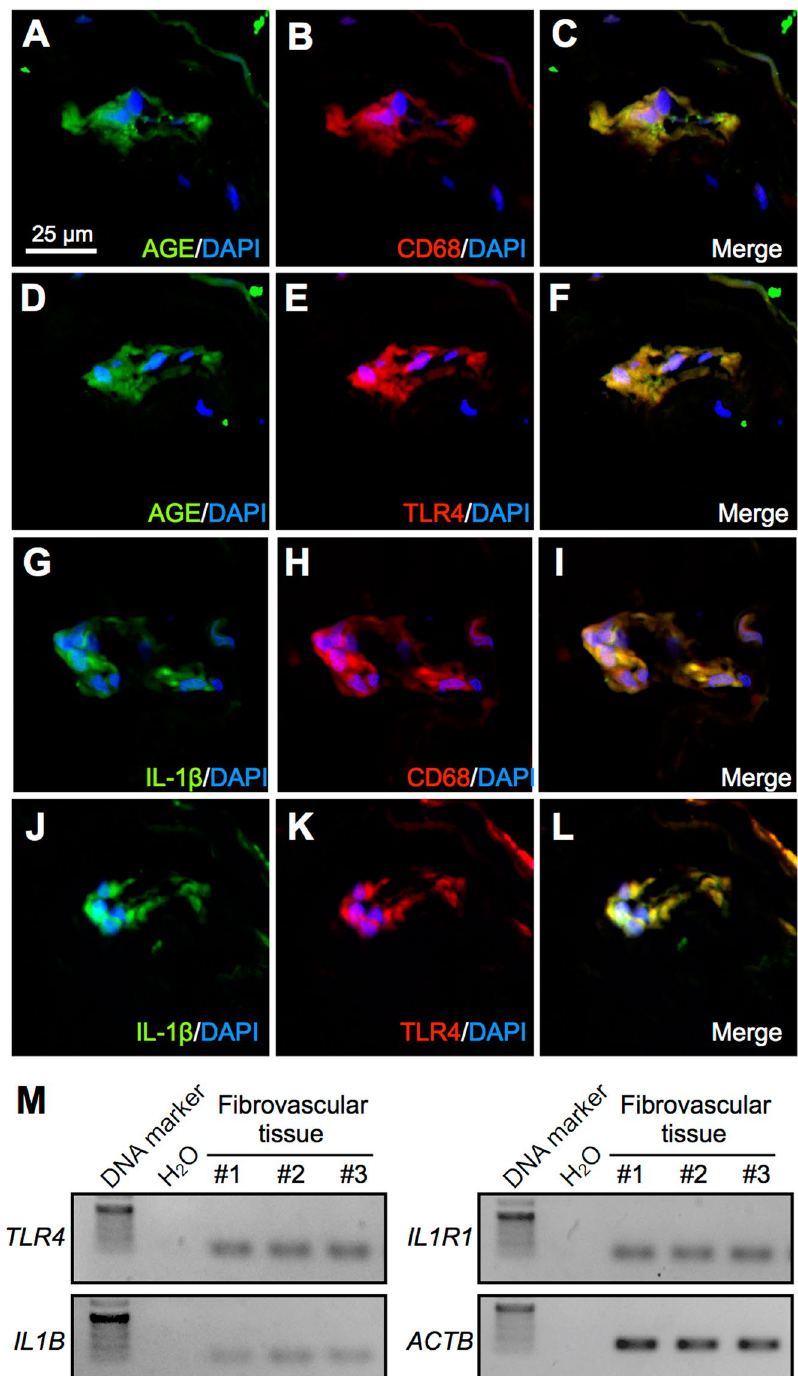
Figure 7. Tissue co-localization of AGE, TLR4 and IL-1 β in macrophages. ( A–L ) Double labeling of AGE ( green ), CD68 ( red ) and DAPI ( blue ) ( A–C ); AGE ( green ), TLR4 ( red ) and DAPI ( blue ) ( D–F ); IL-1 β ( green ), CD68 ( red ) and DAPI ( blue ) ( G–I ); IL-1 β ( green ), TLR4 ( red ) and DAPI ( blue ) ( J–L ) in PDR fibrovascular tissues. Scale bar = 25 μ m. ( M ) Gene expression of TLR4 , IL1B , and IL1R1 in PDR fibrovascular tissues. Full- length gels are presented in Supplementary Fig.